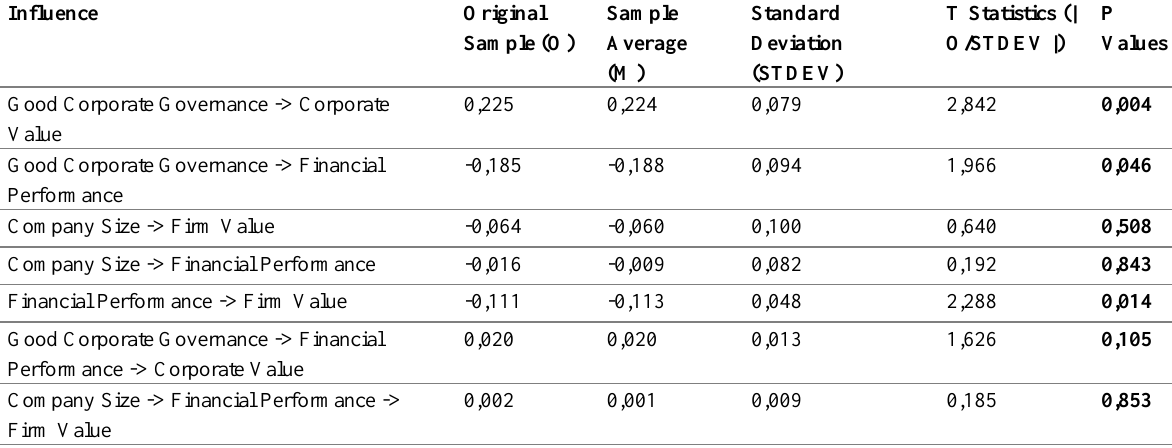
Table 7 : Hypothesis Testing